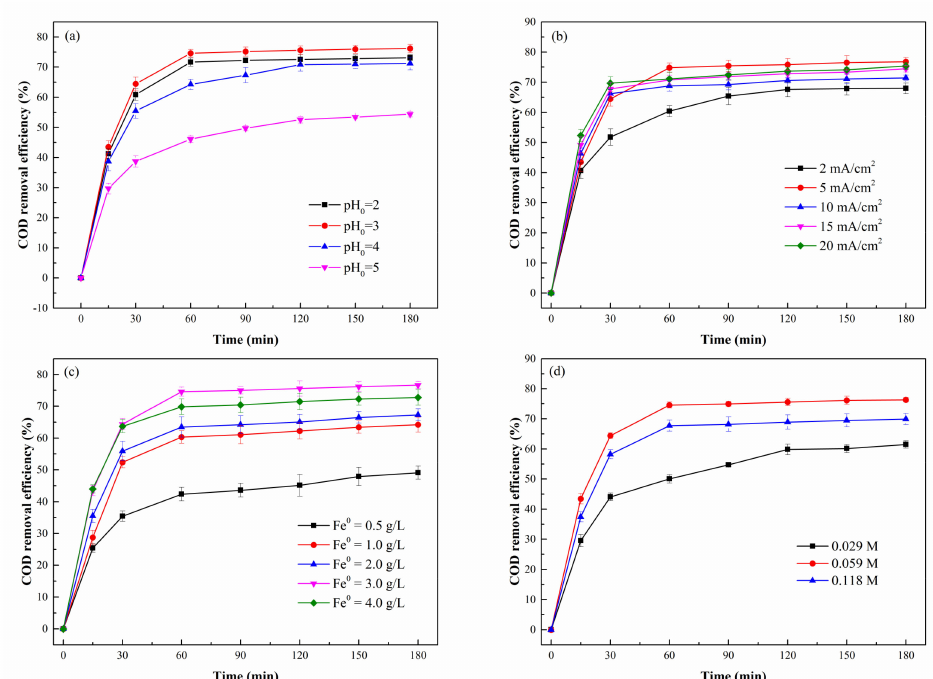
Figure 5. Effect of pH 0 ( a ), current density ( b ), Fe 0 dosage ( c ), and H 2 O 2 dosage ( d ) on COD removal efficiency in the electro-Fe 0 /H 2 O 2 reaction. Except for the investigated parameter, other parameters were controlled as follows: pH 0 = 3.0, current density = 5 mA/cm 2 , Fe 0 dosage = 3 g/L, H 2 O 2 dosage = 0.059 M, and reaction time = 180